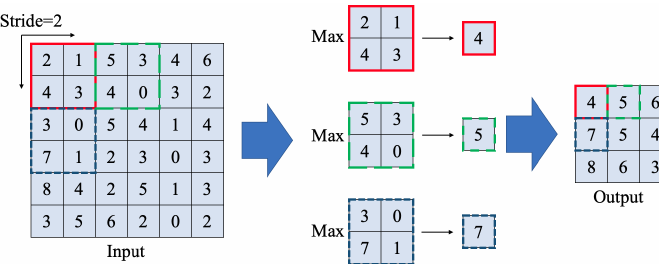
Figure 3. Example of MaxPooling layer.